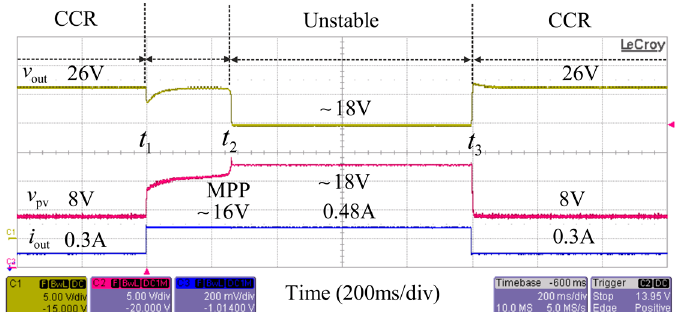
Figure 26. Behavior of boost-converter output voltage ( v out ) and current ( i out ) as well as PV-generator voltage ( v pv ), when the operating point reaches the MPP due to a step change in the output current of the boost converter (i.e., at time t 1 ).